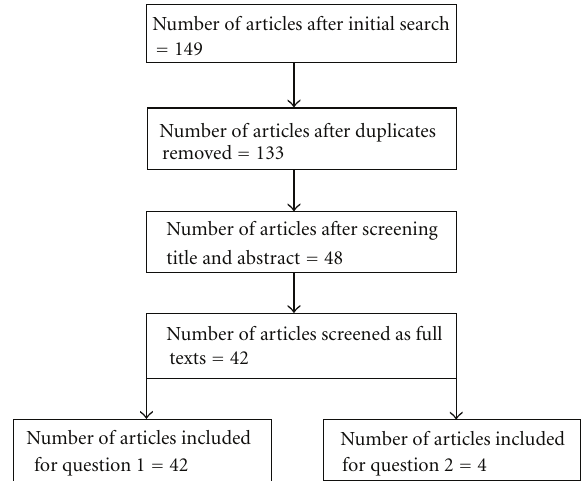
Figure 1: Yield of articles for the robotics